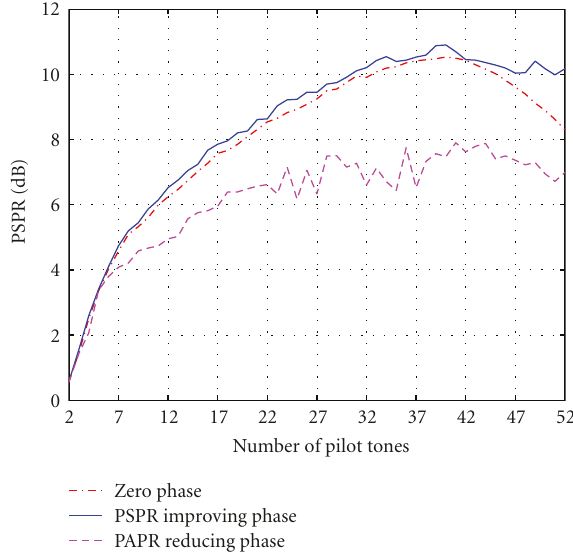
Figure 11: PSPR comparison of waveforms generated by using zero, PSPR, and PAPR reducing phases.